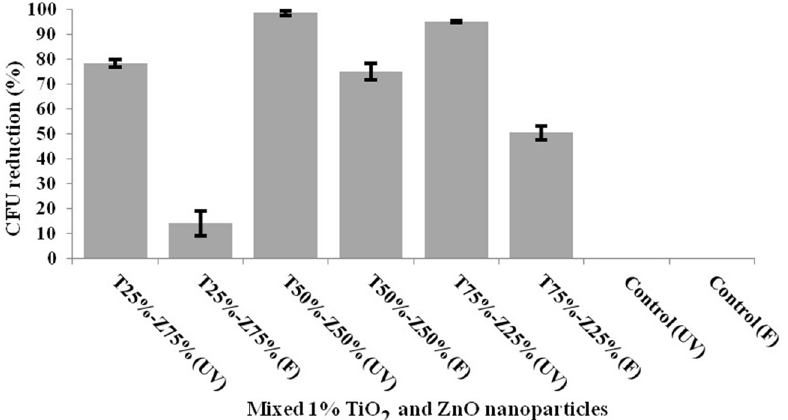
Fig. 6. Direct bactericidal effects of 1% mixed of TiO fluorescent and UV lights at 20 o C